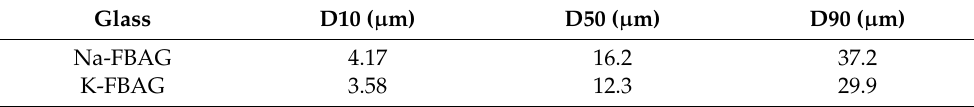
Table 2. Composition of 45S5 (NovaMin and